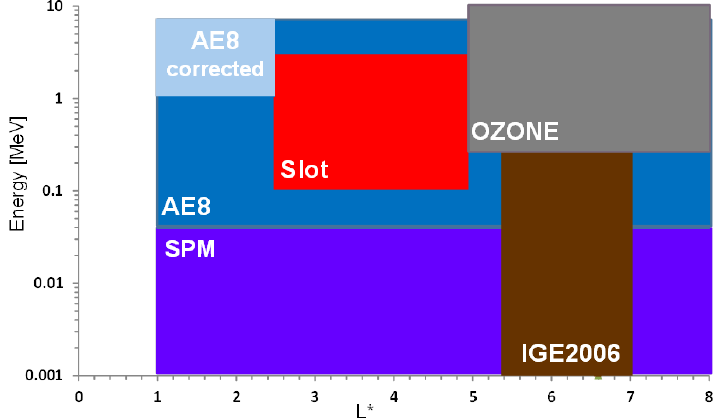
Figure 2. Energy and L coverage of the different models integrated in GREEN- e